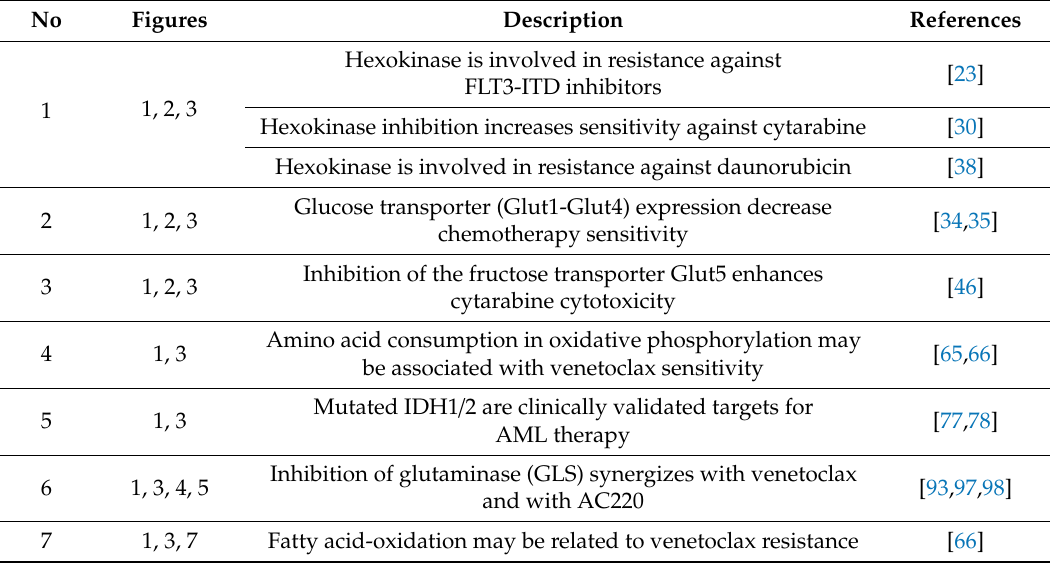
Table 1. Reviewed possible metabolic response determinants in AML. Numbers (No) correspond to the circled numbers indicated in the respective